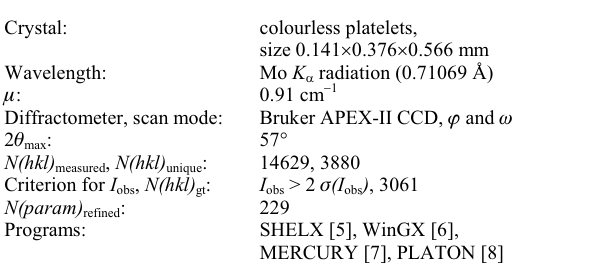
Table 1. Data collection and